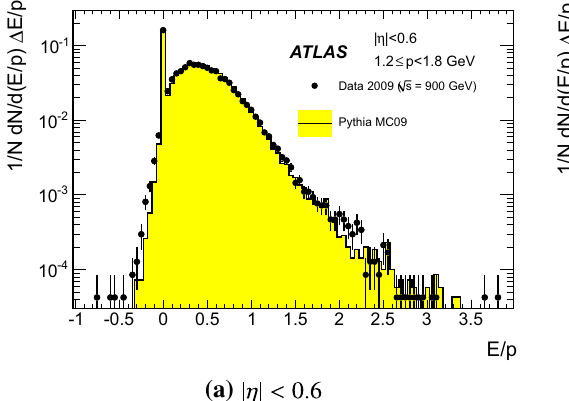
Fig. 19 The distribution of E / p , the ratio of the calorimeter energy E and the track momentum p , for ( a ) central tracks with 1 . 2GeV < p < 1 . 8GeVand( b )forward-goingtrackswith2 . 8GeV < p < 3 . 6GeV,for